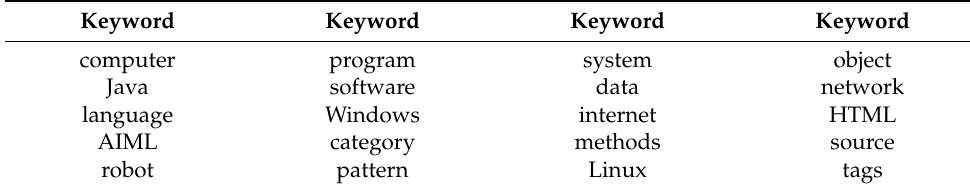
Table 1. Example of top